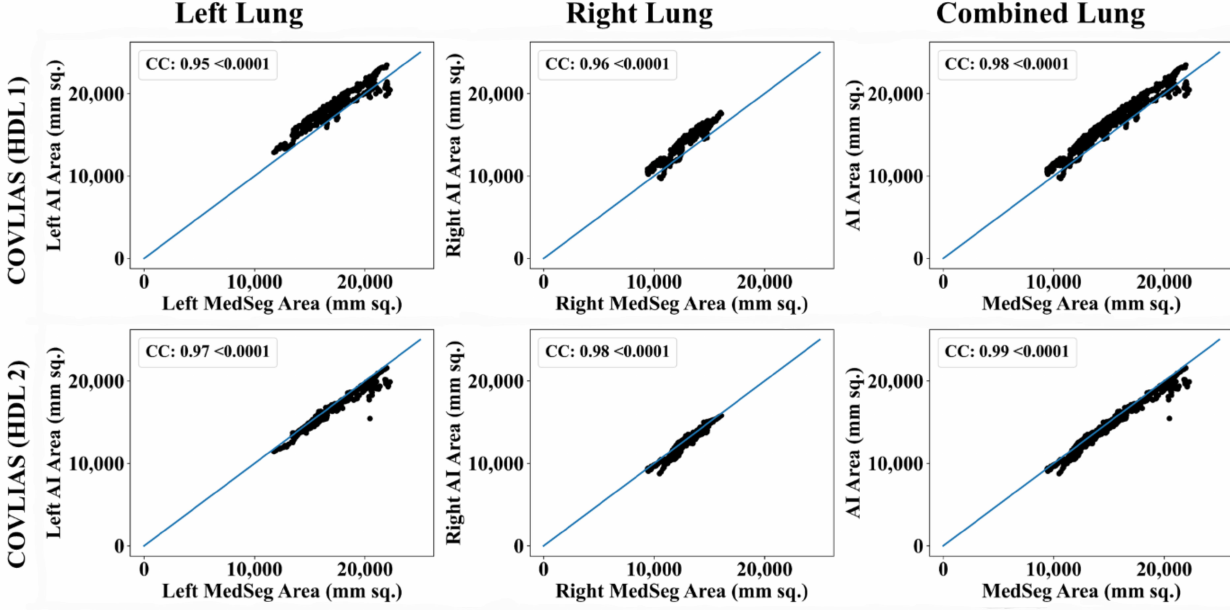
Figure 19. CC plot: COVLIAS 1.0 vs. MedSeg. Column 1: left lung, column 2: right lung, and column 3: combined lungs. COVLIAS (HDL 1): VGG-SegNet; COVLIAS (HDL 2):